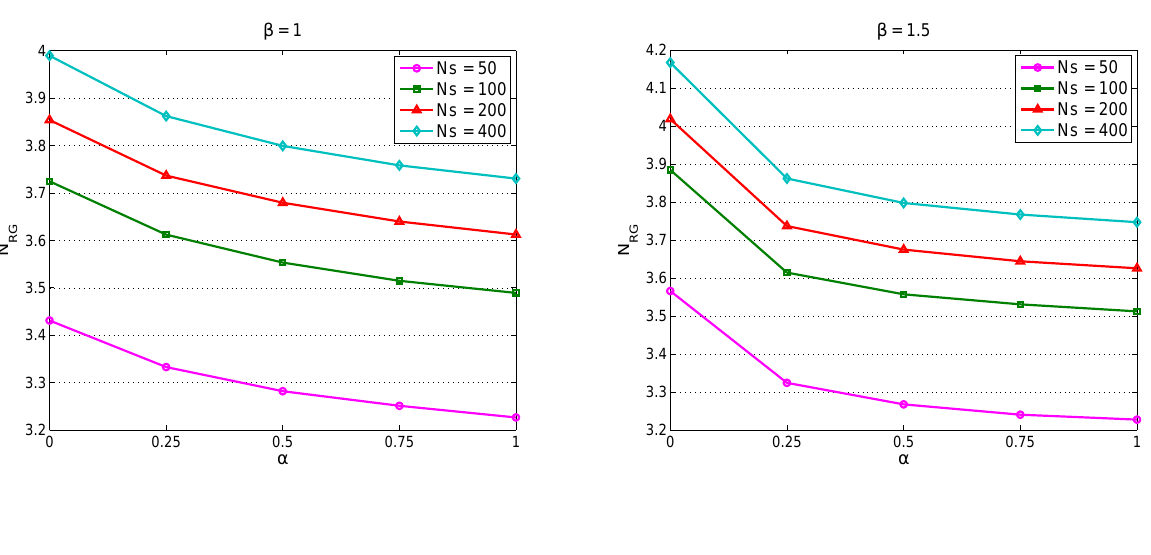
versus β with α = 0 (left) and N RG